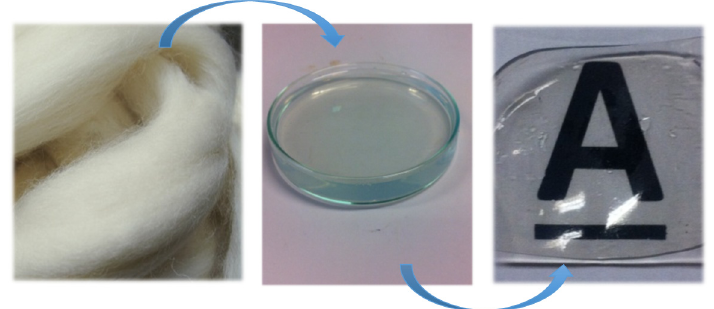
Figure 10. This schematic shows the process in which keratin film has been produced, starting from wool fibres, and the final product, which is the transparent and robust keratin film. Middle image shows transparent keratin extract.